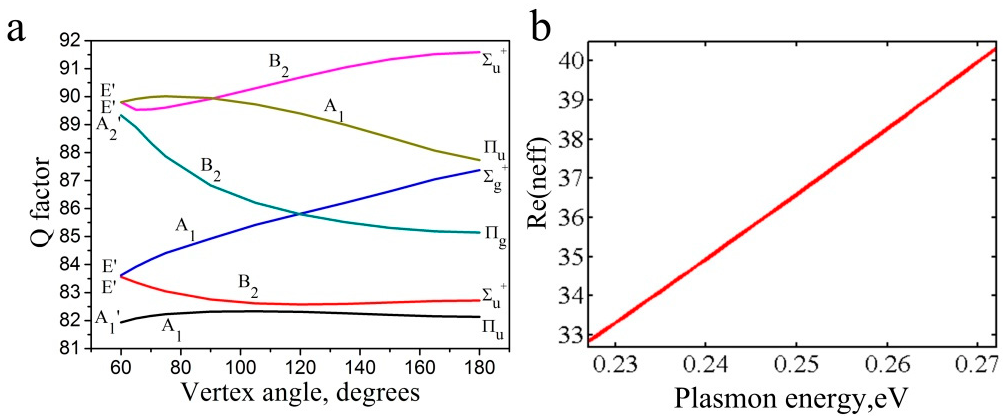
Figure 5. ( a ) Quality factor ( Q factor) as a function of the the vertex angle ( θ ), ( b ) the real part of effective refractive index as a function of the plasmon energy.